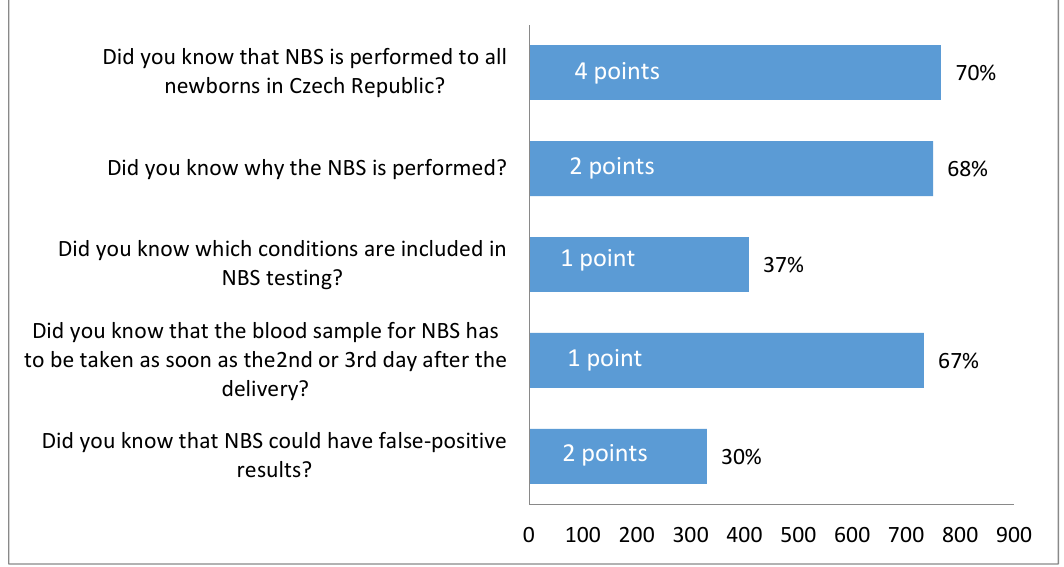
Figure 1. Participants’ responses to questions evaluating awareness about NBS. Corresponding points and percentage positive answers.